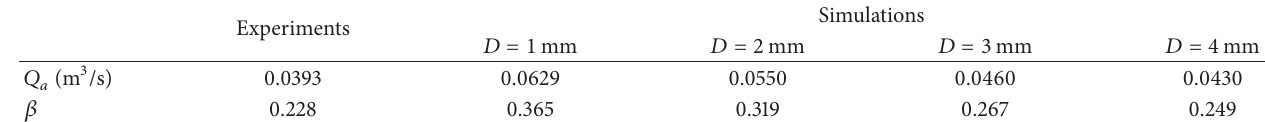
Table 4: Comparison of 𝛽 ’s between experiments and simulations.